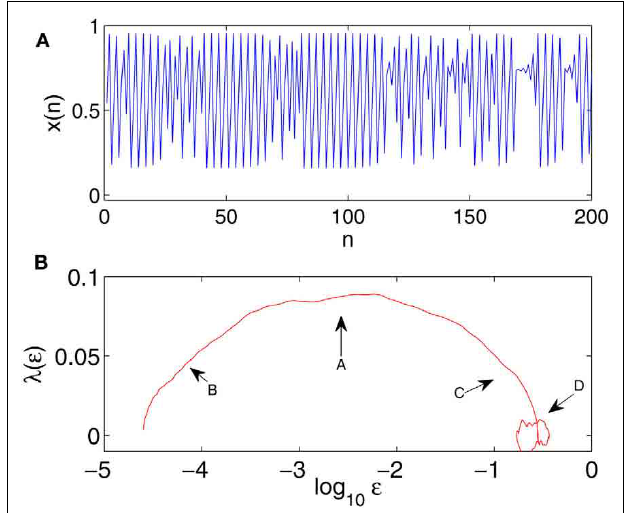
FIGURE 6 | SDLE λ ( ε ) vs. ε curves for the simulation data. Eight different H values are considered.To put all the curves on one plot, the curves for different H values (except the smallest one considered here) are arbitrarily shifted